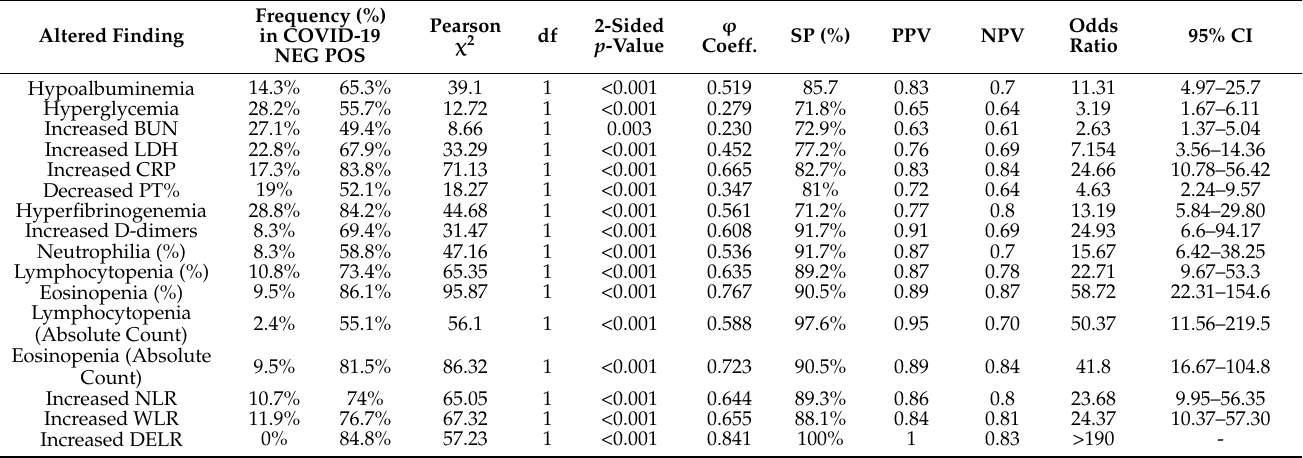
Table 3. Frequency analysis through chi-square test of altered routine blood tests according to laboratory and ROC- established cut-points between groups. All variables were dichotomized according to standard laboratory ranges apart from NLR and WLR, which were considered abnormally increased according to ROC-established thresholds. SP, specificity; PPV, positive predictive value; NPV, negative predictive value (sensitivity corresponds to frequency for each group). Altered